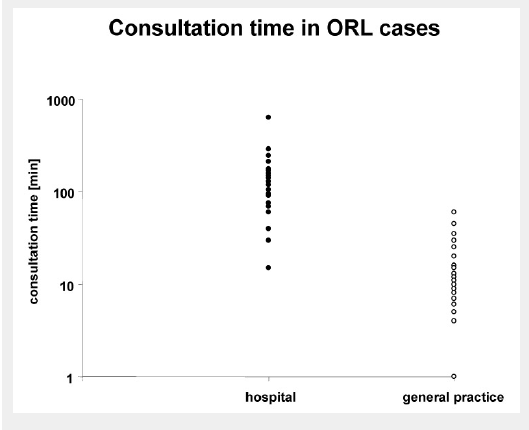
Consultation time as a marker for clinical performance at the emergency ward (hospital) and general practice. Only outpatients attending for ENT reasons were taken into analysis. There was a statistical significant and clinically relevant difference in consultation